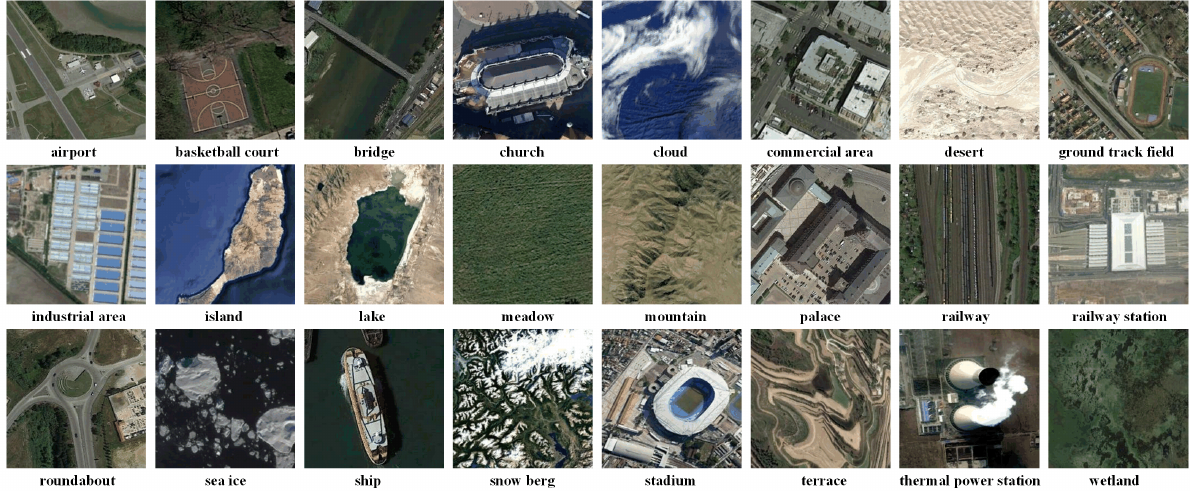
Figure 6. Example images from the NWPU-RESISC45